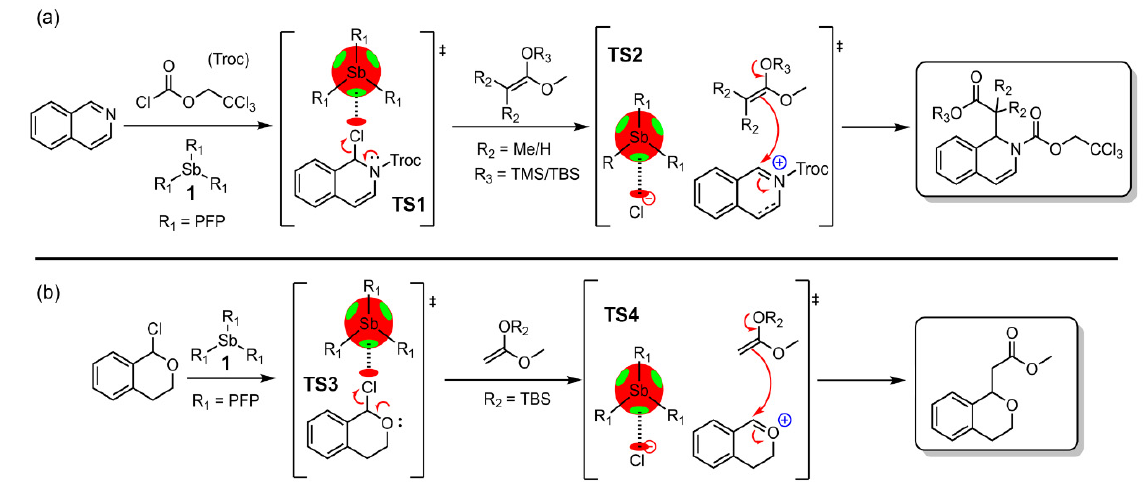
Figure 4. ( a ) Proposed reaction pathways of the Reissert-type substitution of isoquinolines and ( b ) the transformation of 1-chloroisochromane to an ester, including a schematic representation of the plausible stabilized transition states (TS1-4) through Sb-PnBs.